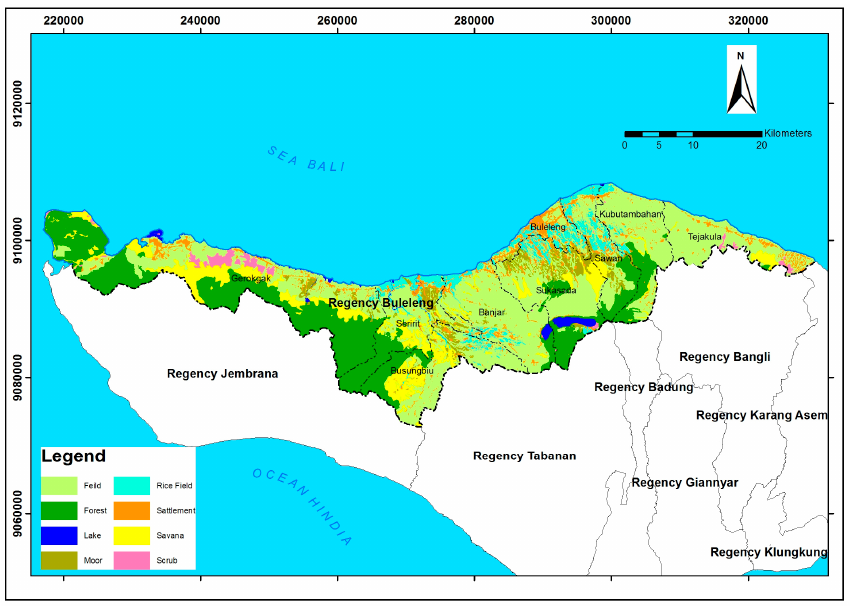
Figure 11. Vegetation coverage of the study area